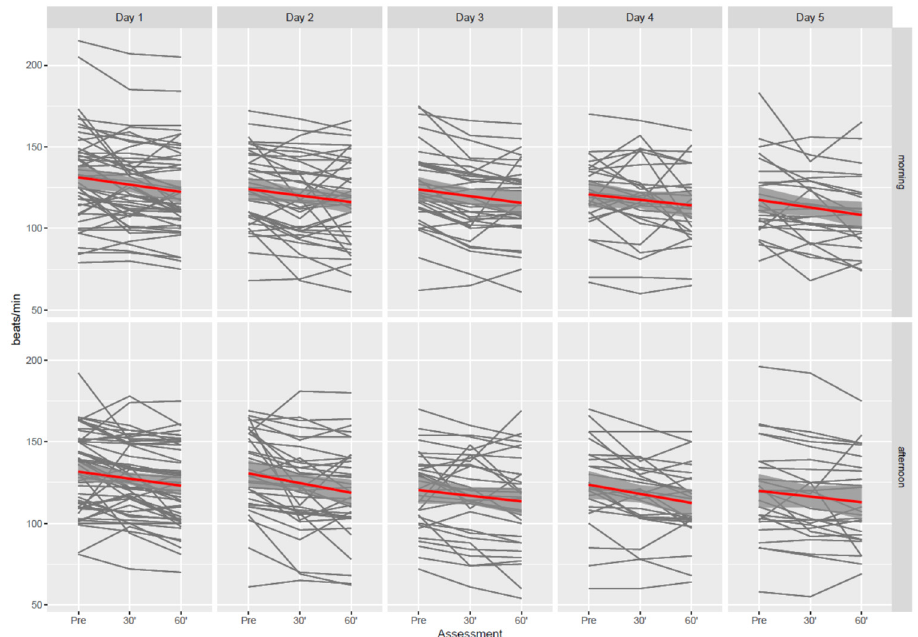
Figure 2. Time profiles of heart rate in the 59 participants from day 1 to day 5. Red solid line denotes regression line with 95% Confidence Intervals (grey bands).